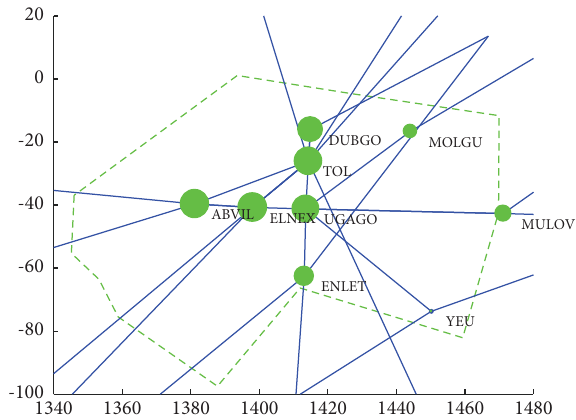
Figure 14: Te fight interactions at each waypoint from 9:00 to 9: 59.